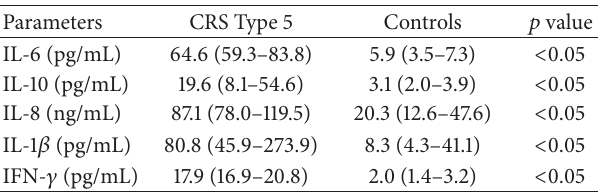
Table 3: Evaluation of immune-mediated molecules in CRS Type 5 plasma and controls.